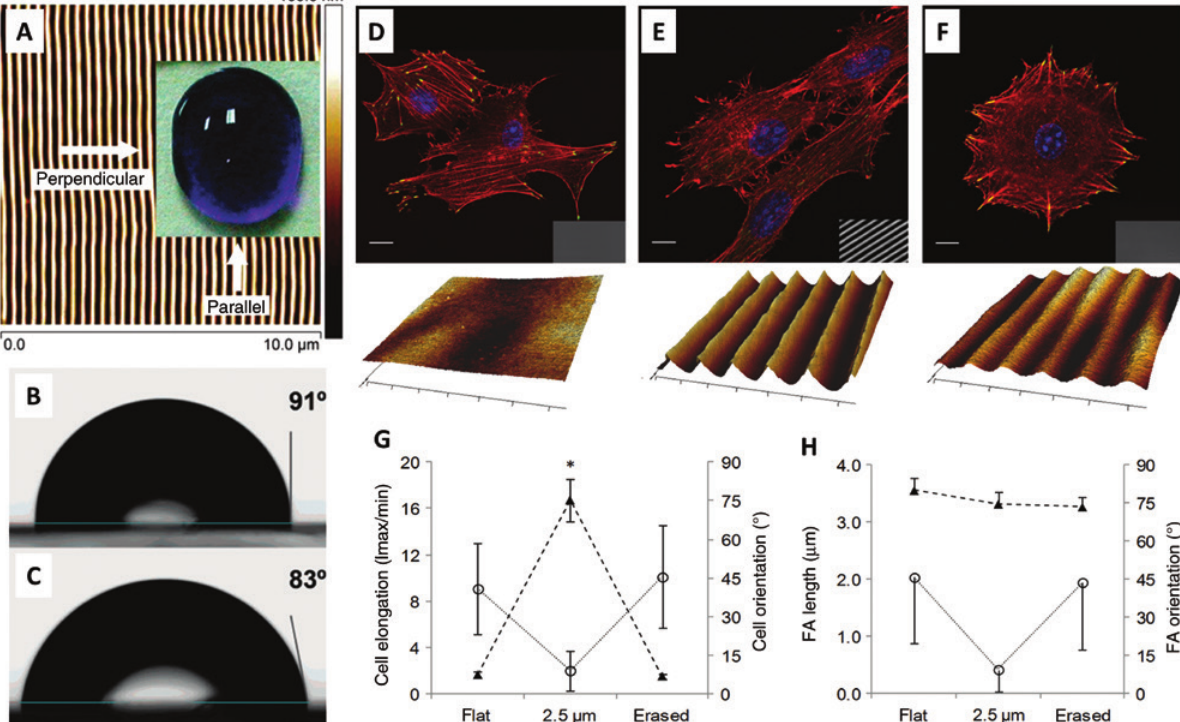
Figure 12: Anisotropic wettability and adhesion properties of sinusoidal 1D SRGs. (A) Topographical AFM image of a sinusoidal SRG and (inset) top view of a 5- μ l water droplet containing blue dye. (B) and (C) Side views of the droplet seen from the direction parallel and perpendicular to the SRG grooves, respectively. Adapted with permission from Ref. [199], copyright 2007, American Chemical Society. Confocal images of NIH-3T3 cells cultivated on (D) flat azopolymer substrate, (E) patterned sinu- soidal SRGs, (F) erased SRGs. Scale bars: 10 μ m. (G) Plots of cell elongation and cell orientation. (H) Plots of the FA length ( ▲ ) and orienta- tion (○). Reproduced with permission form Ref. [202], copyright 2015, American Chemical